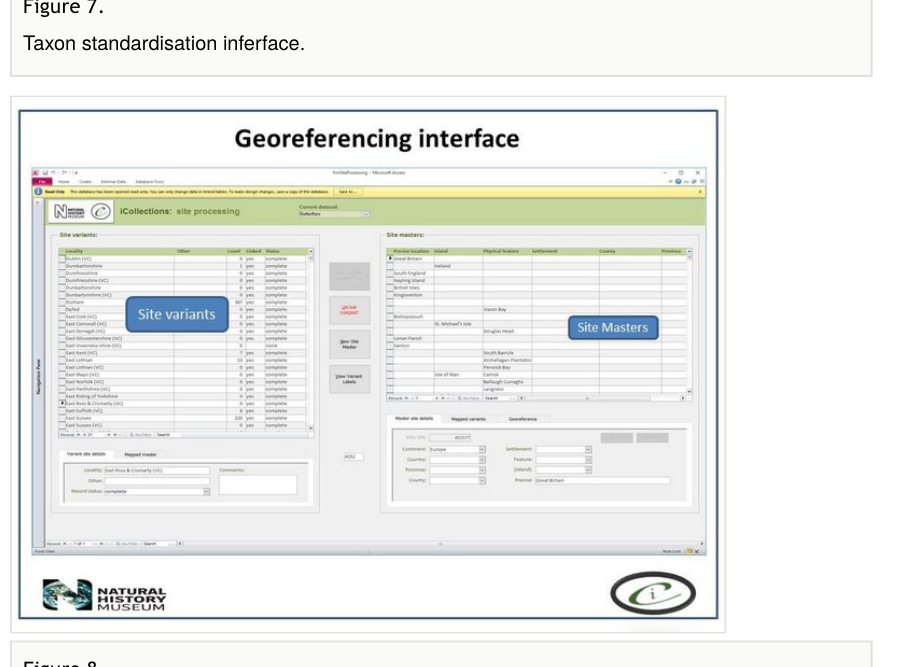
Figure 8. Georeferencing site variant harmonisation